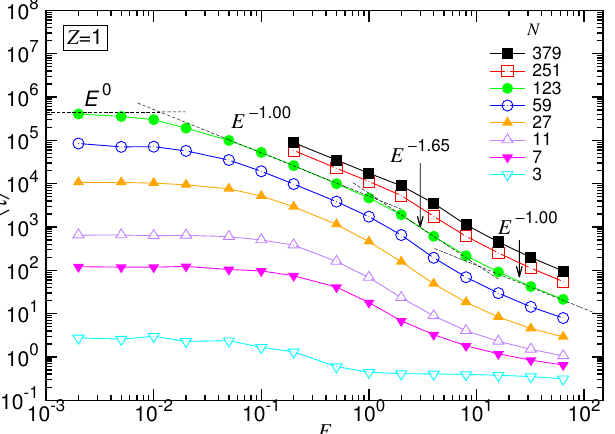
Figure 4. Mean translocation time (cid:104) τ (cid:105) as a function of the driving field E in the monovalent salt solution. The value of N can be read in the legend. The dashed lines show the four predicted scaling behaviors for N =